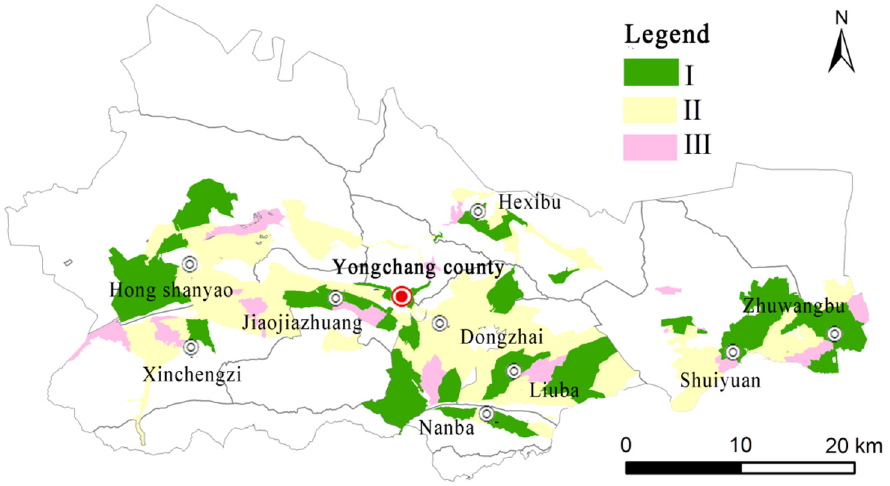
Figure 5. Spatial distribution of the combinations of function-balancing strategies in the countryside.